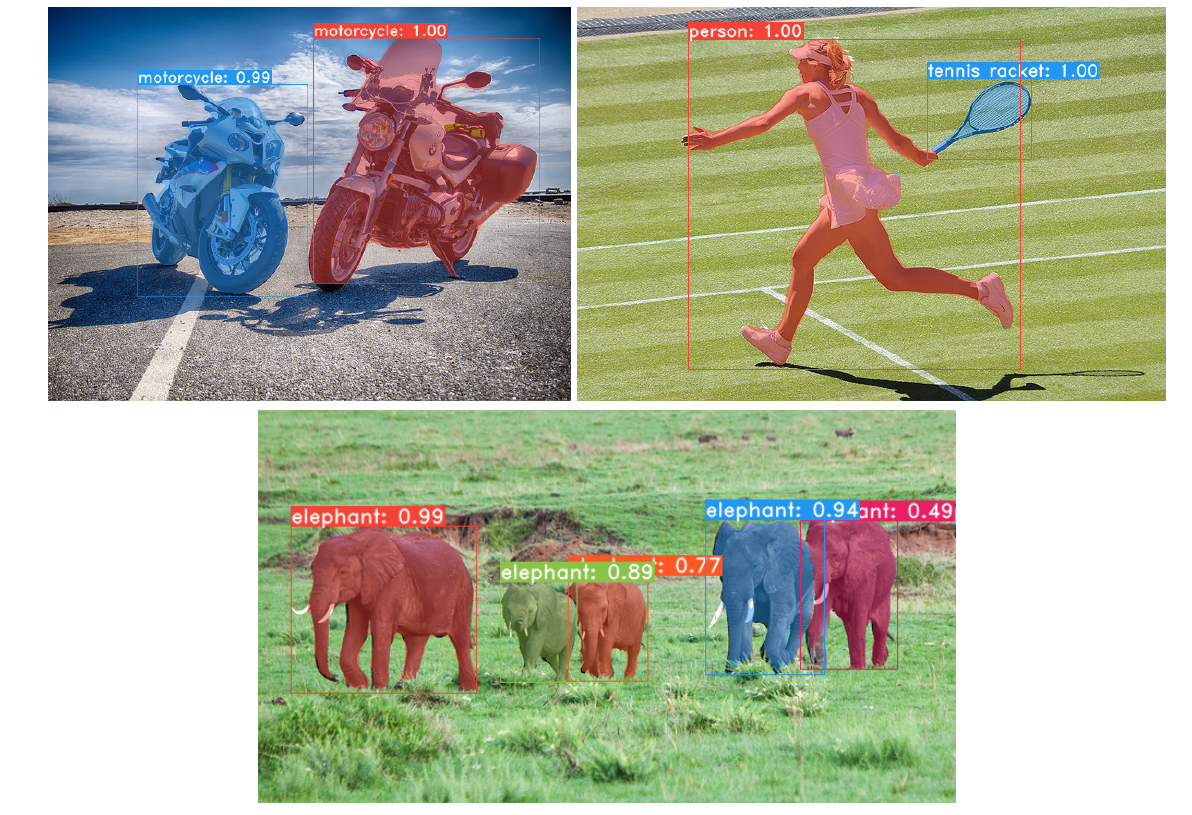
Figure 1. Example of deep image